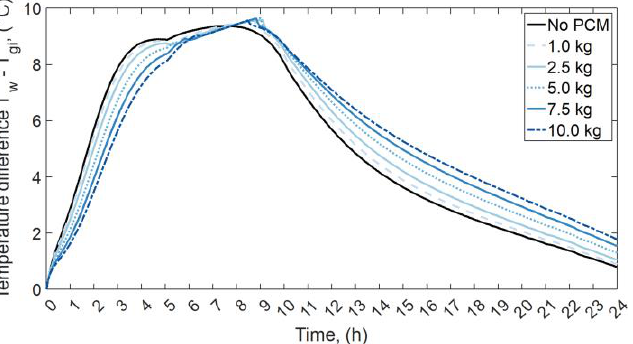
Figure 12. The temperature difference between water and inner glass cover in the SS with different masses of PCM — Case 1. masses of PCM—Case 1.